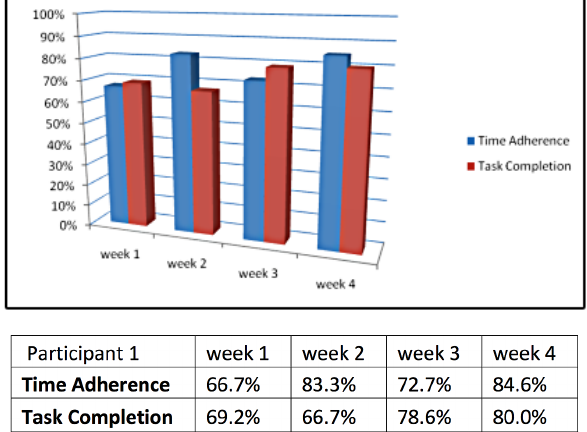
Figure 1. Time adherence and task completion: Performance of Participant 1 over four